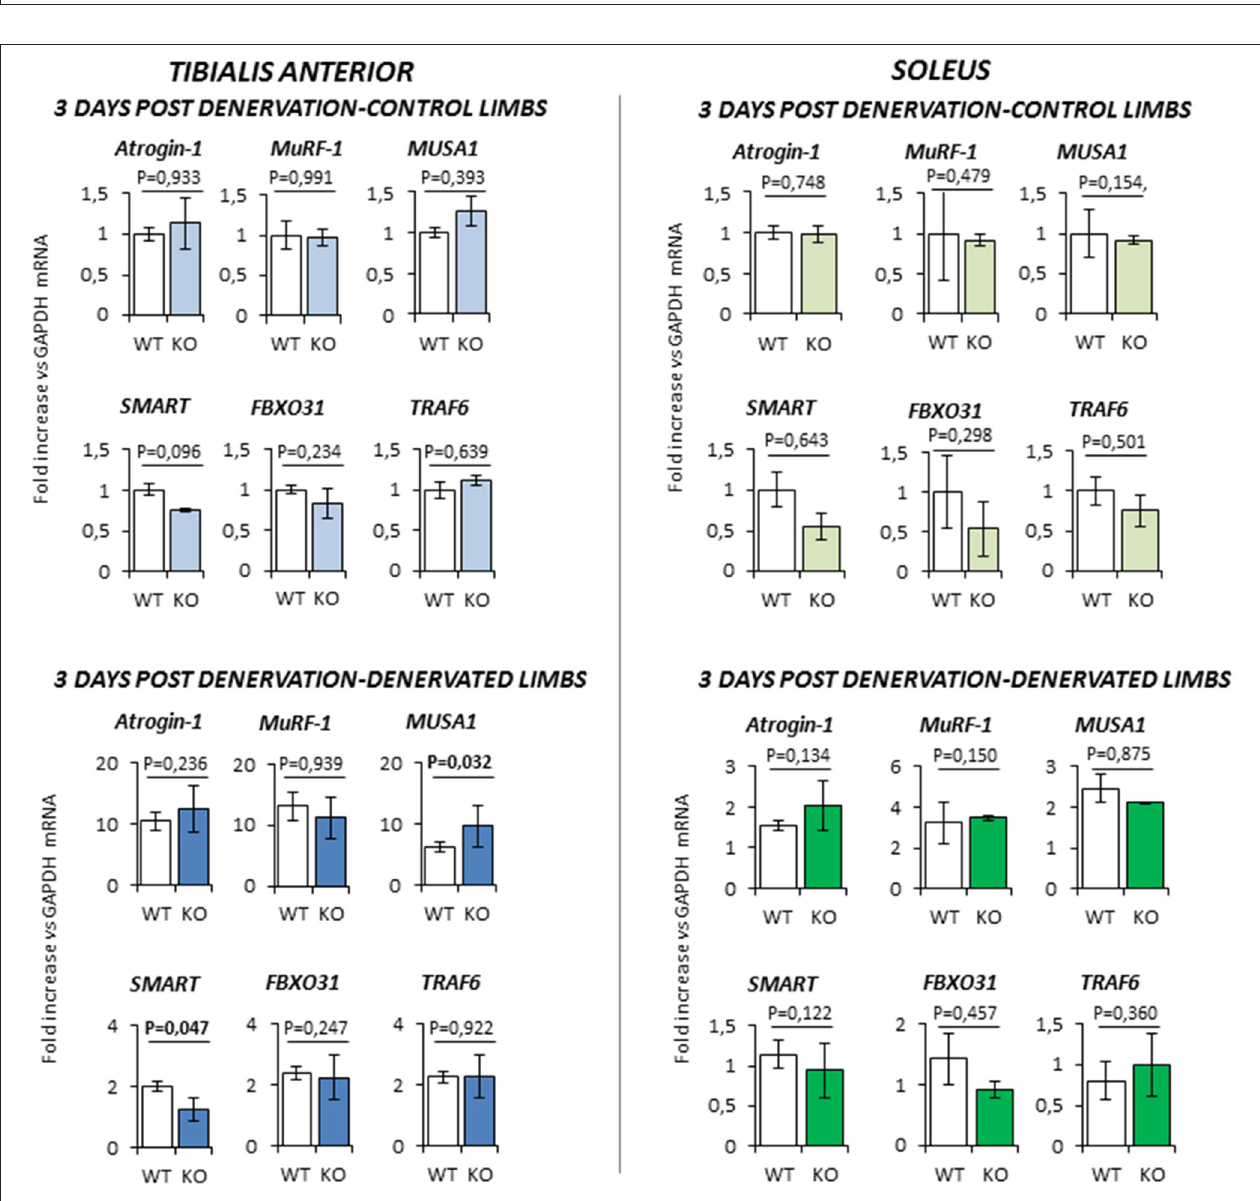
FIGURE 4 | specimens were obtained by succinate-dehydrogenase (SDH) staining, distinguishing β -oxidative (purple), and glycolytic fibers (pale). Data in soleus muscle specimens were obtained by myosin-heavy chain immune-staining, distinguishing fast (green), and glycolytic fibers (dark). Representative microscopic fields are given. Results on fiber composition and cross section area are reported respectively as percentage of fiber-type per muscle and absolute fiber area ( µ m 2 ). Data on muscle loss after denervation were obtained as percentage of cross section area reduction in denervated (DEN) vs. control (CTRL) limbs.Data are reported as mean values ± standard error of the mean. Significance: P -values between compared conditions are reported. Significant differences ( P < 0.05) are highlighted in bold.